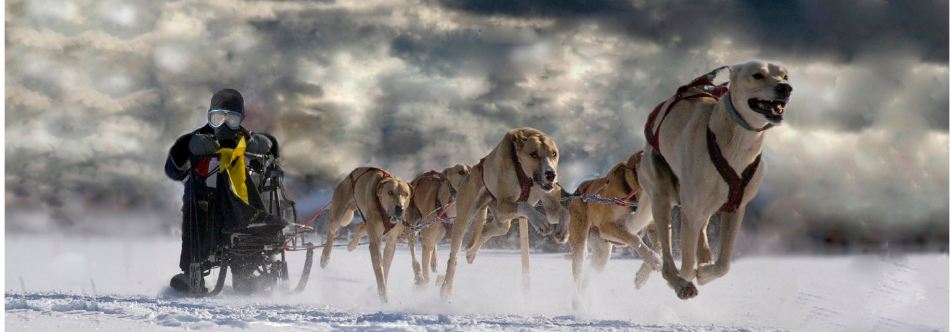
Figure 1. Short-haired sled dogs undertaking flexion and extension of the spine during a middle- distance dog-sled race (Lekkarod TM